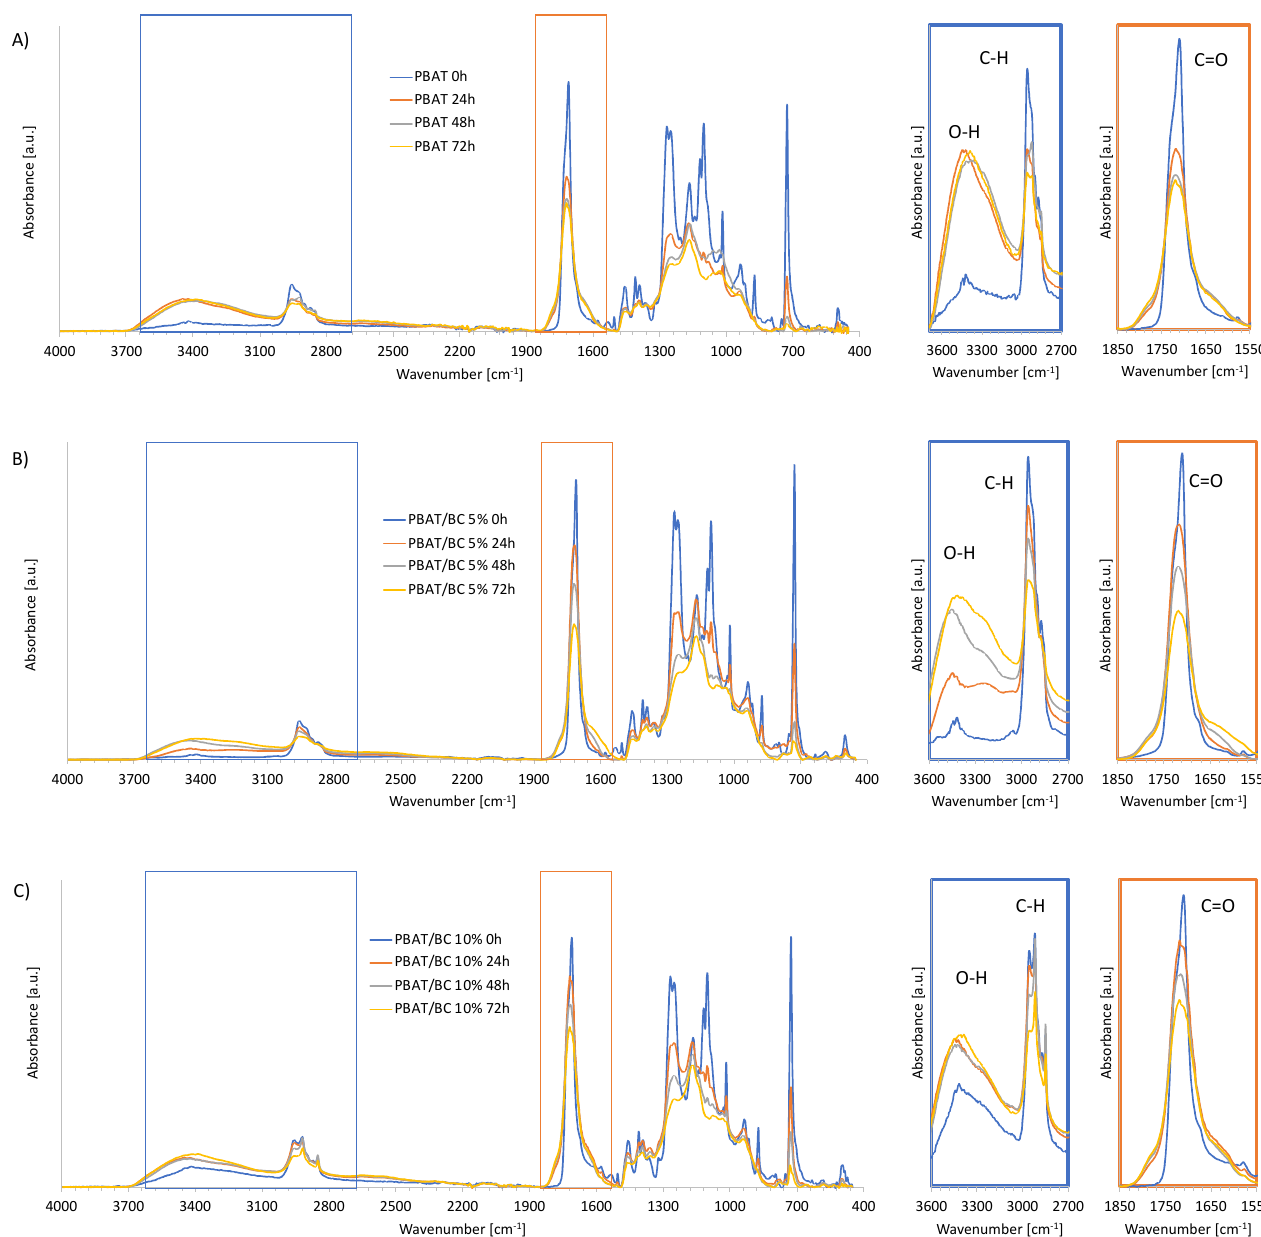
Figure 12. FTIR spectra as a function of photo-oxidation time of ( A ) PBAT, ( B ) PBAT/BC 5%, and ( C ) PBAT/BC 10% blown films.